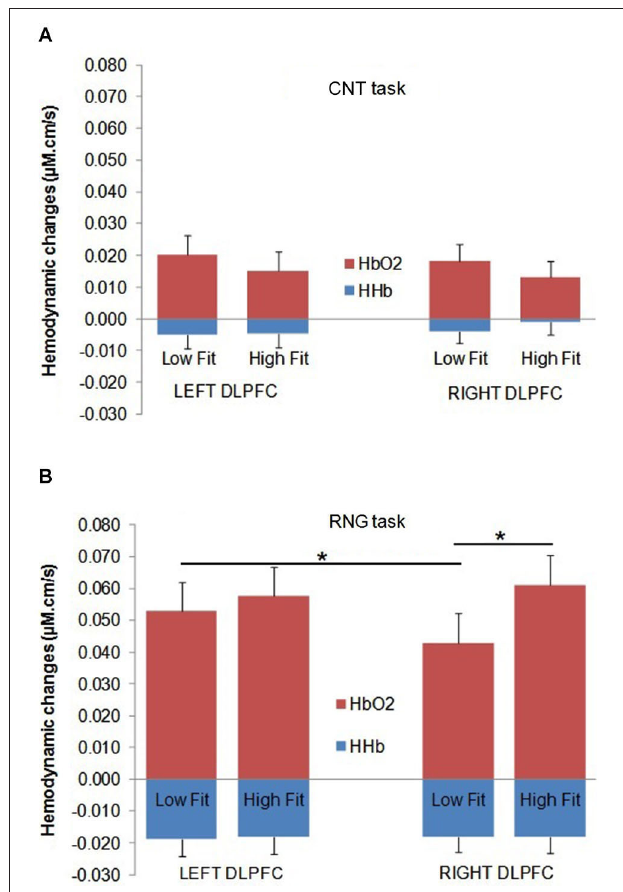
FIGURE 4 | Mean ∆ [HbO 2 ] slope coefficients (in red) and mean ∆ [HHb] slope coefficients (in blue) in µ M.cm/s during the CNT task (A) and the RNG task (B) for the Low-fit group and the High-fit group in the Left DLPFC (left panel) and in the Right DLPFC (right panel) . Bars represent standard-errors. * p <